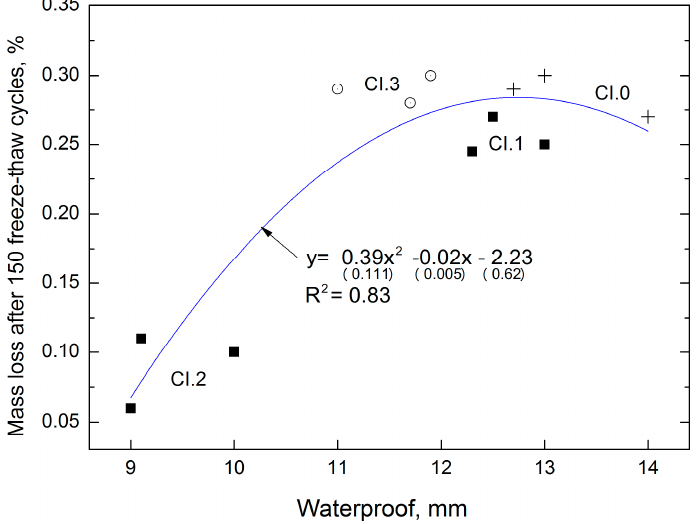
Figure 7. Dependence between water-tightness and mass loss after 150 freeze–thaw cycles of CI concrete.